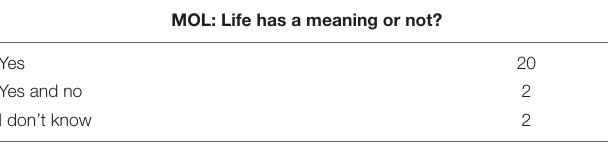
TABLE 4 | Frequencies of coded category “Life has a meaning or not”.